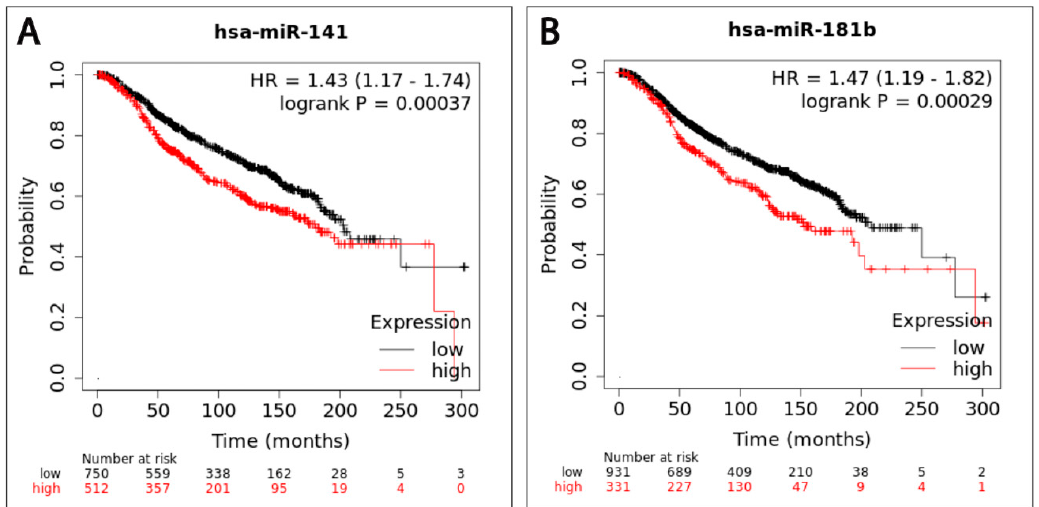
Figure 4. Overall survival curves for miR-141 and miR-181b in 1262 breast cancer patients using the KM plotter miRNA breast cancer online database. Kaplan–Meier curves are plotted for OS of breast cancer patients demonstrating that patients with high expression of ( A ) miR-141 and ( B ) miR-181b are associated with shorter overall survival.